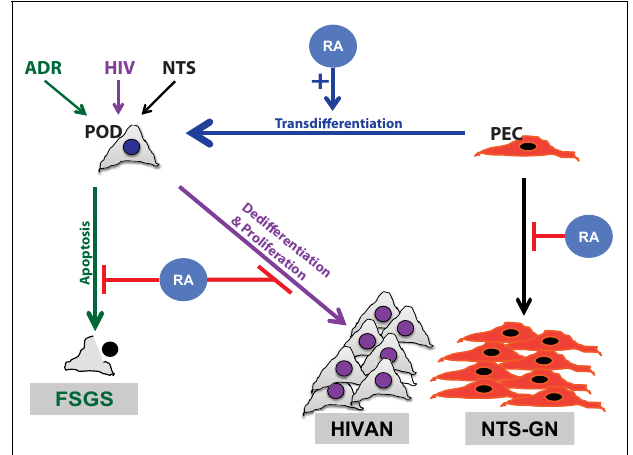
FIGURE 1 | Schematic diagram of retinoids in podocyte injury . Retinoic acid (RA) has been demonstrated to play a critical role in attenuation of podocyte injury.The mechanism by which RA abrogates podocyte injury is dependent on the type of inciting injury. Podocyte apoptosis is improved with RA treatment in a murine model of adriamycin-induced nephropathy, focal segmental glomerulosclerosis (FSGS) model (green). Podocyte dedifferentiation is attenuated with RA treatment in models of HIV-associated nephropathy (HIVAN) (purple). In a murine model of crescentic glomerulonephritis, using nephrotoxic serum (NTS), RA treatment minimized parietal epithelial cell (PEC) proliferation (black) and restored podocytes by PEC trans differentiation